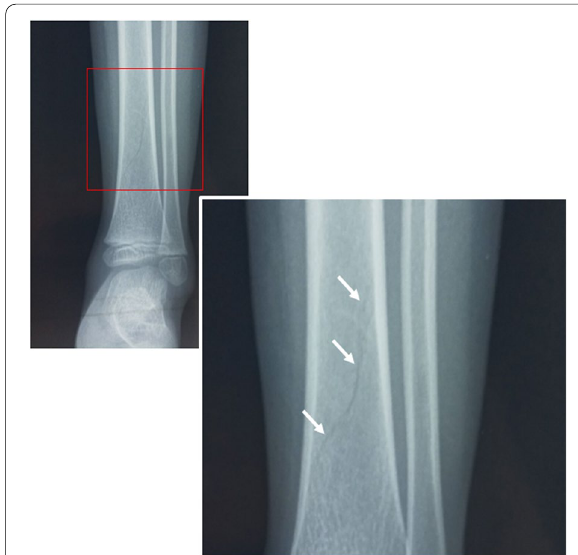
Fig. 5 Subperiosteal fracture. Distal left leg anteroposterior x-ray shows an oblique fracture line (white arrows) on the distal third of the diaphysis that does not affect any of the two intact cortices, realizing a toddler’s type I